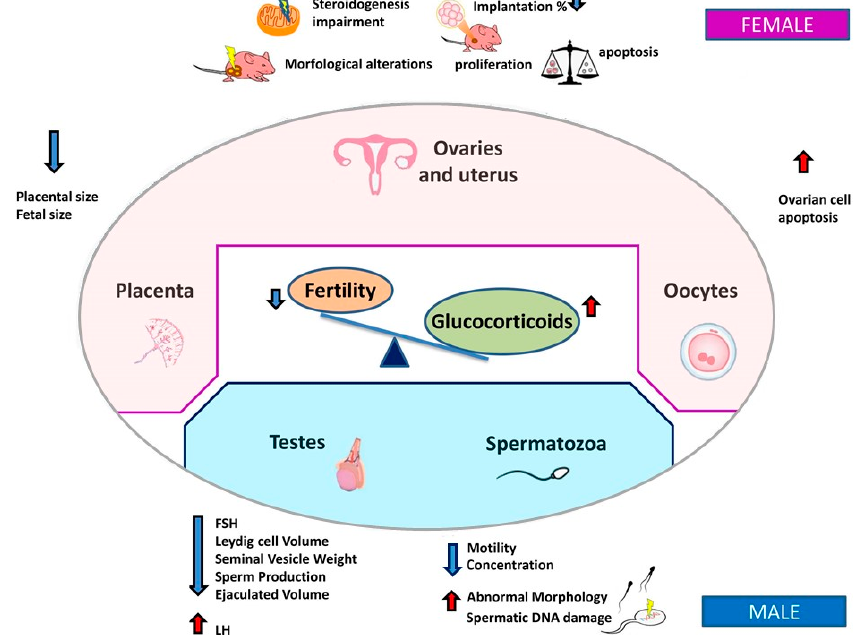
Figure 2. Infertility is associated with unbalanced GCs levels. The reciprocal relationship between the disruption of circadian rhythms of GCs and fertility may be either the cause or the effect of female and male infertility.